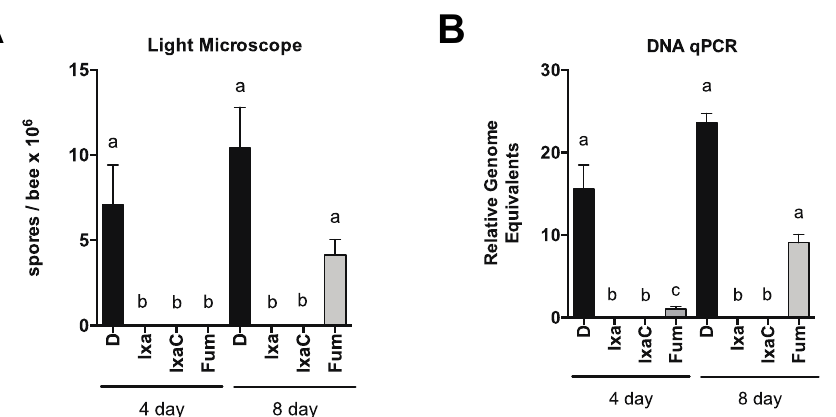
Figure 5. Ixazomib stably reduces N. ceranae infection in newly eclosed bees. N. ceranae levels in midguts of infected newly eclosed bees fed sucrose solution containing DMSO or ixazomib for 4 days before switching to DMSO alone, as determined by spore count using light microscopy ( A ) or by qPCR ( B ) a ≠ b, p < 0.05.